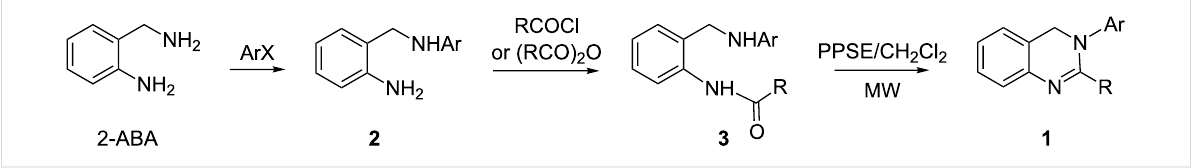
Scheme 1: Synthetic pathway leading to N -aryl-3,4-dihydroquinazolines 1 .